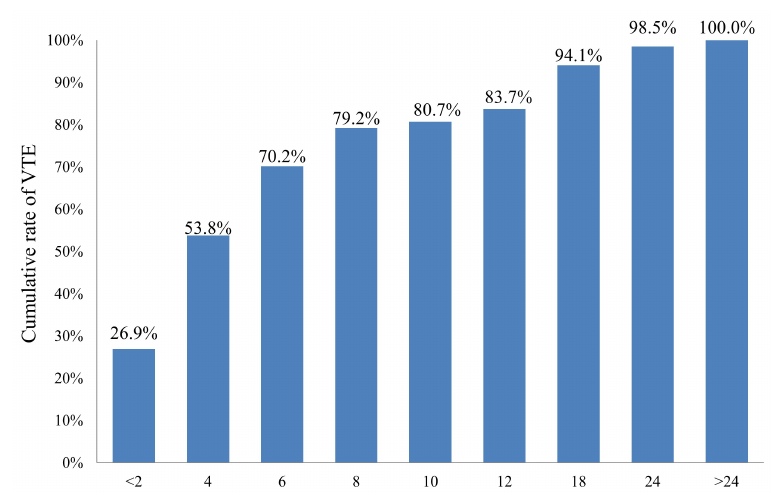
Figure 2. Cumulative rate of VTE among 67 VTE patients.